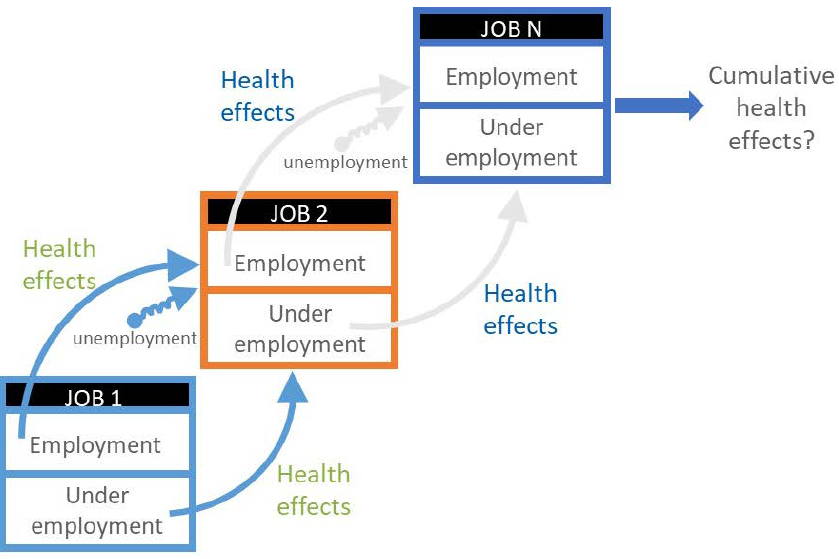
Figure 2. Model of health burden along the working-life continuum [11].